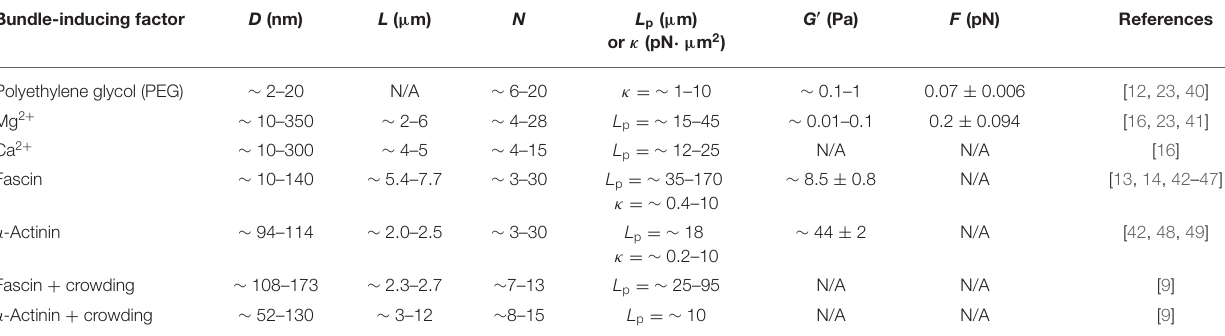
TABLE 1 | The geometric and mechanical properties of actin bundles induced by crowding, cations, and actin-crosslinking proteins. Bundle-inducing factor